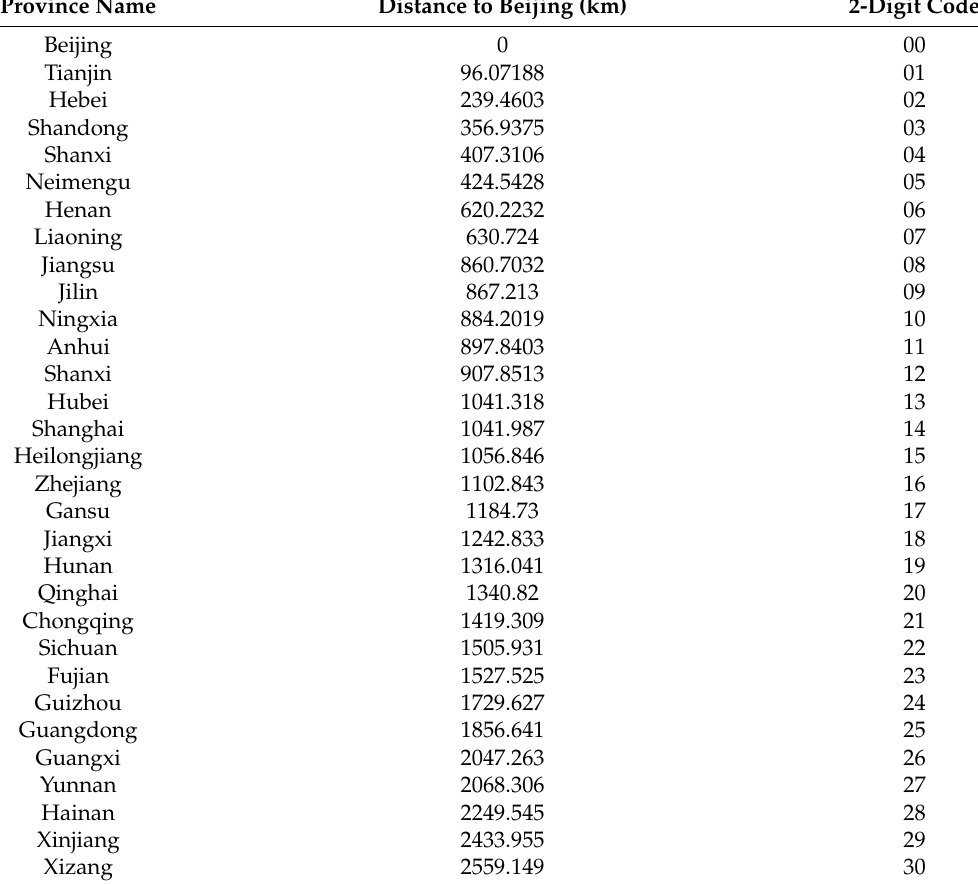
Table A1. The transfer two-digit code based on distance between Beijing and each province of China. Province Name Distance to Beijing